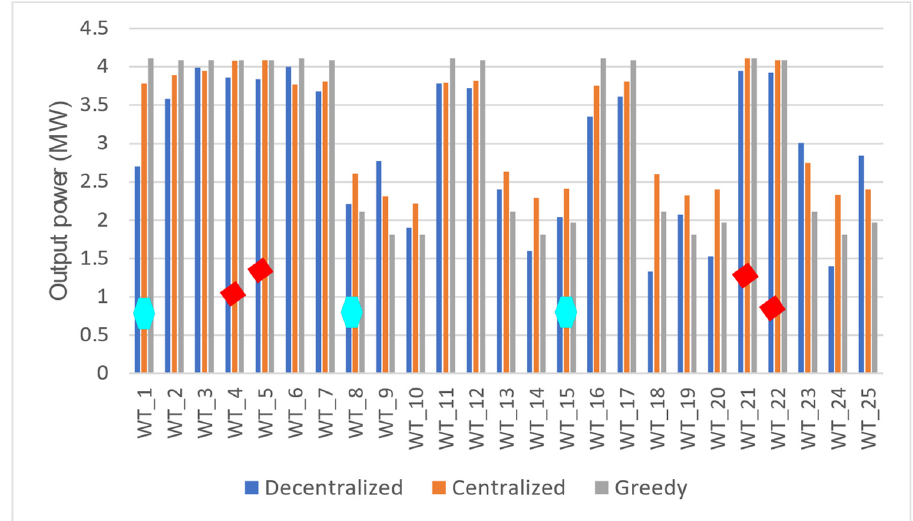
Figure 8. The respective power output of wind turbine: ϕ = 45 ◦